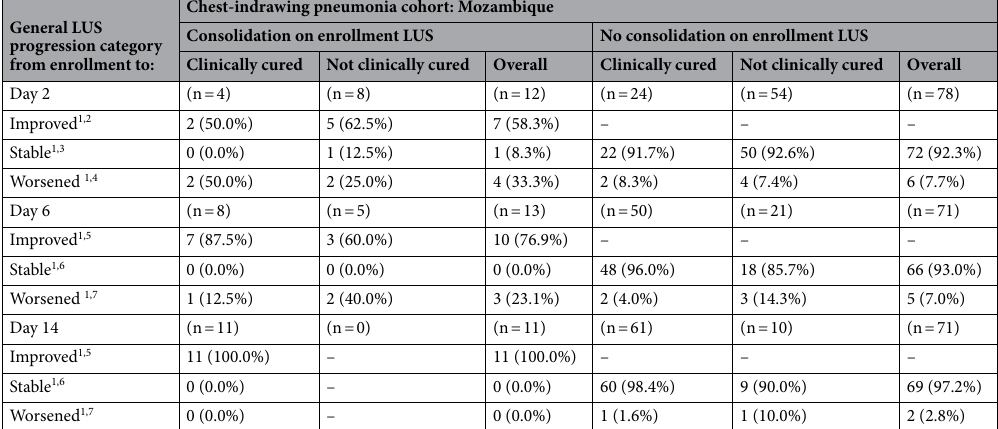
Table 3. Progression of consolidation on lung ultrasound (LUS) by Days 2, 6 and 14 clinical status in Mozambique. 1 Percentage of children with known progression category. 2 Comparison of enrollment and Day 2 LUS showing decreased number or size(s) ≥ 0.5 cm of consolidation(s), without any increase(s). 3 Comparison of enrollment and Day 2 LUS showing no observed changes to number or size(s) ≥ 0.5 cm of consolidation(s). 4 Comparison of enrollment and Day 2 LUS showing increased number or size(s) ≥ 0.5 cm of consolidation(s). 5 Comparison of enrollment and Day 6 or Day 14 (as applicable) LUS showing decreased number or size(s) ≥ 1 cm of consolidation(s), without any increase(s). 6 Comparison of enrollment and Day 6 or Day 14 (as applicable) LUS showing no observed changes to number or size(s) ≥ 1 cm of consolidation(s). 7 Comparison of enrollment and Day 6 or Day 14 (as applicable) LUS showing increased number or size(s) ≥ 1 cm of